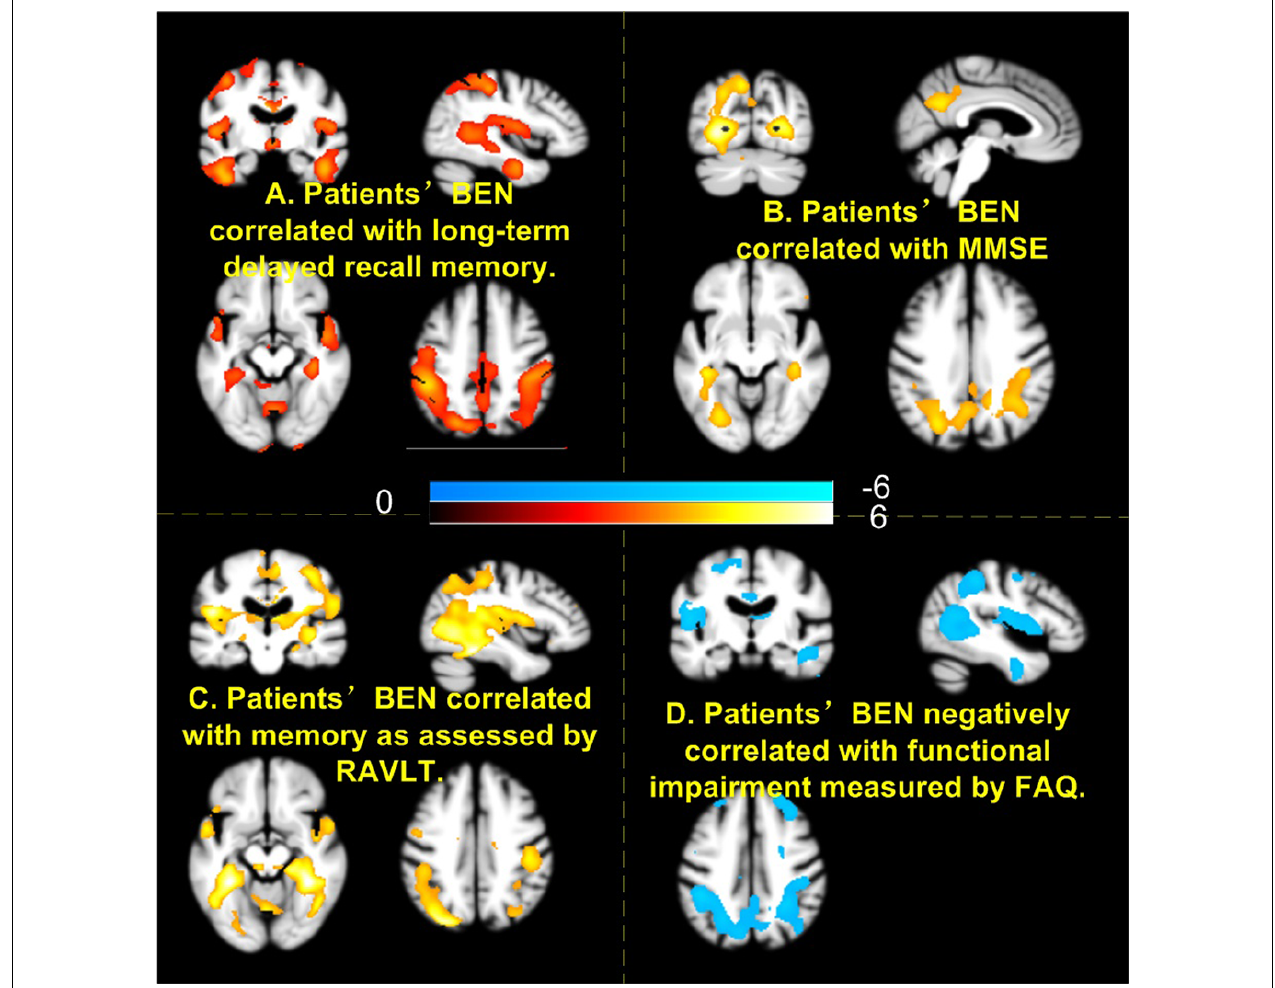
FIGURE 5 | Higher brain entropy (BEN) in parietal cortex, temporal cortex associated with more severe impairment of memory (A,C) , cognitive (B) , and daily functions (D) . Red and cool colors mean positive and negative correlations, respectively. MMSE, Mini-Mental State Examination; RAVLT, Rey Auditory Verbal Learning Test; FAQ, Functional Activity